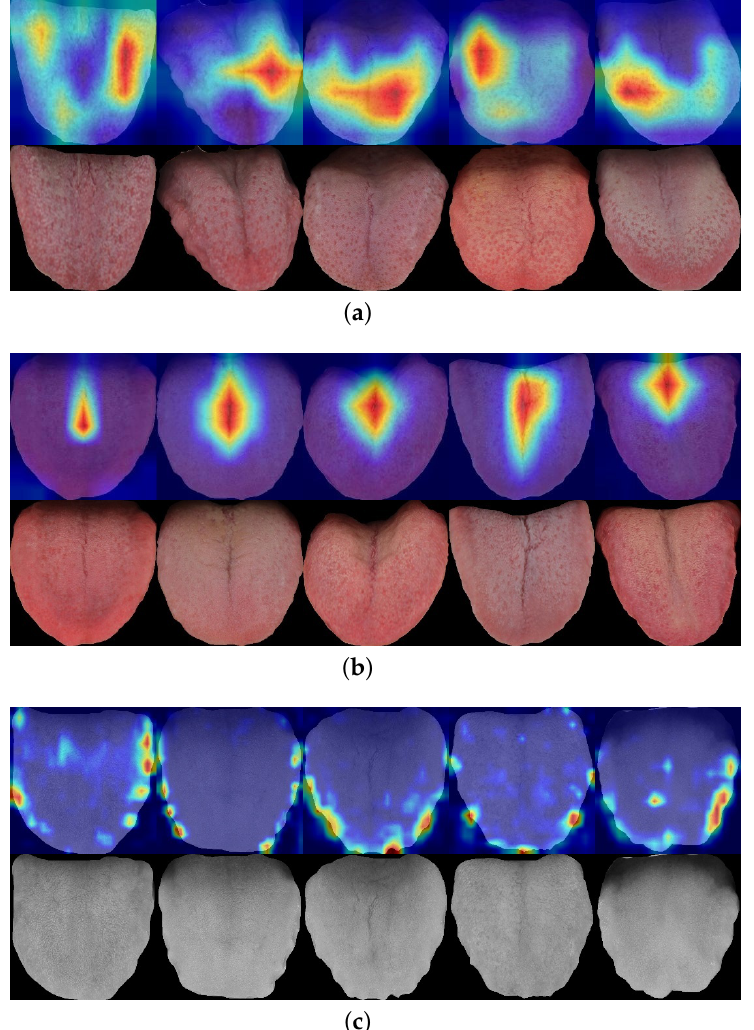
Figure 15. Heat maps of different features: ( a ) spotted tongue, ( b ) fissured tongue, and ( c ) tooth- marked